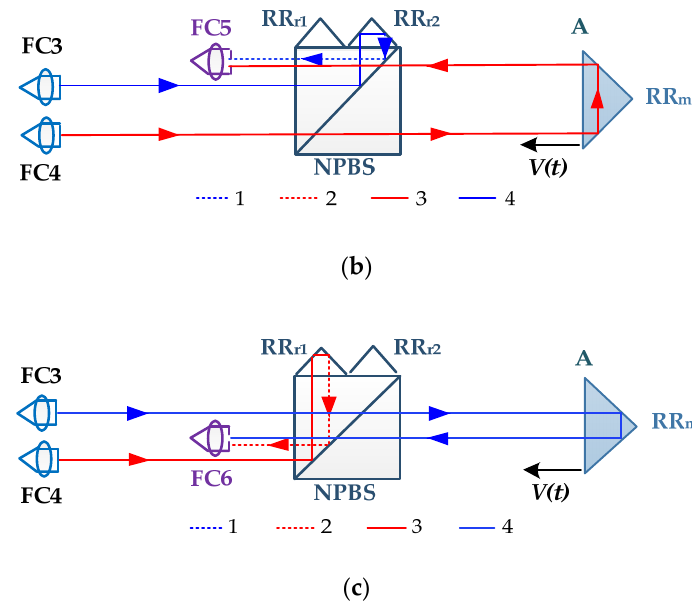
Figure 1. Schematic of the main composition of HSHR-HI (high-speed high-resolution heterodyne interferometer). FC, fiber coupler. NPBS, non-polarizing beam splitter; RR r , retro reflectors for the reference beams; RR m , retro reflectors for the measurement beams; PD, photodetector. ( a ) Overall optical configuration, ( b ) optical path of beams received by FC5, and ( c ) optical path of beams received by FC6.